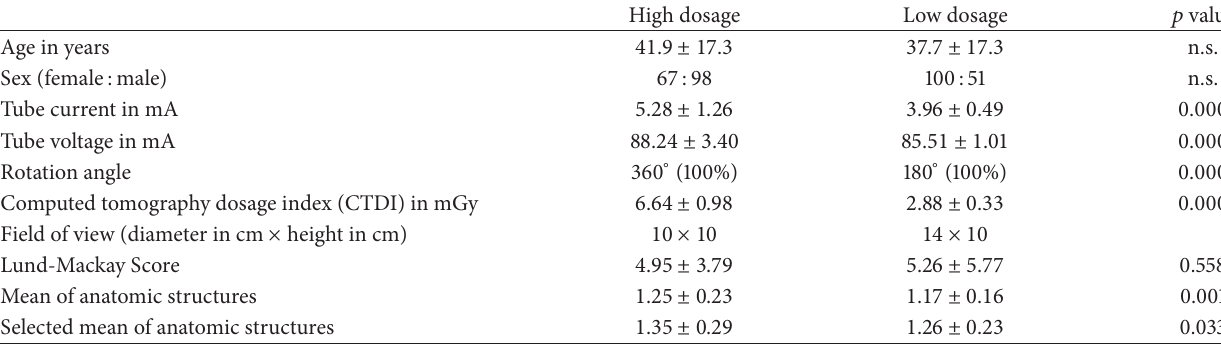
Table 1: Overview of the technical parameters of the X-ray tube, the applied dosage, the Lund-Mackay Score, and the mean evaluation score for all structures and the selected group of anatomical parameters for the two dosage groups.